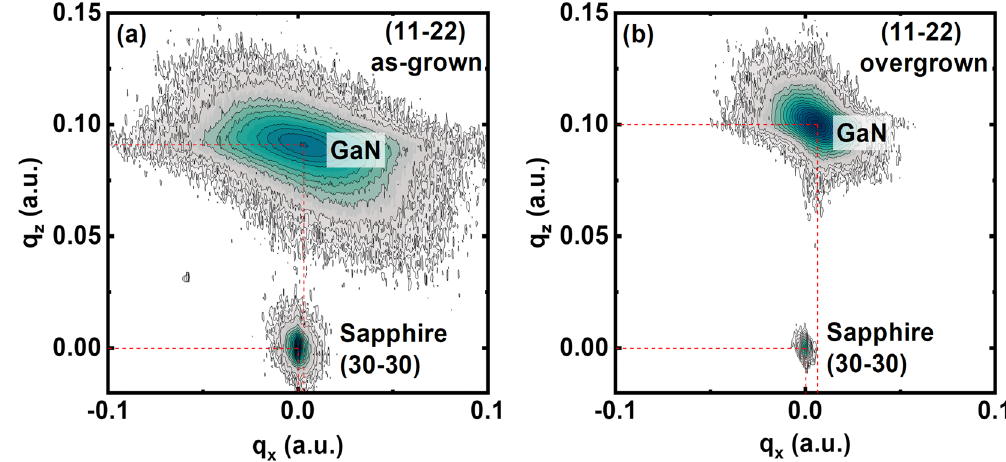
Figure 5. RSM of ( a ) the as-grown sample, and ( b ) the overgrown sample on our regularly arrayed micro-rod